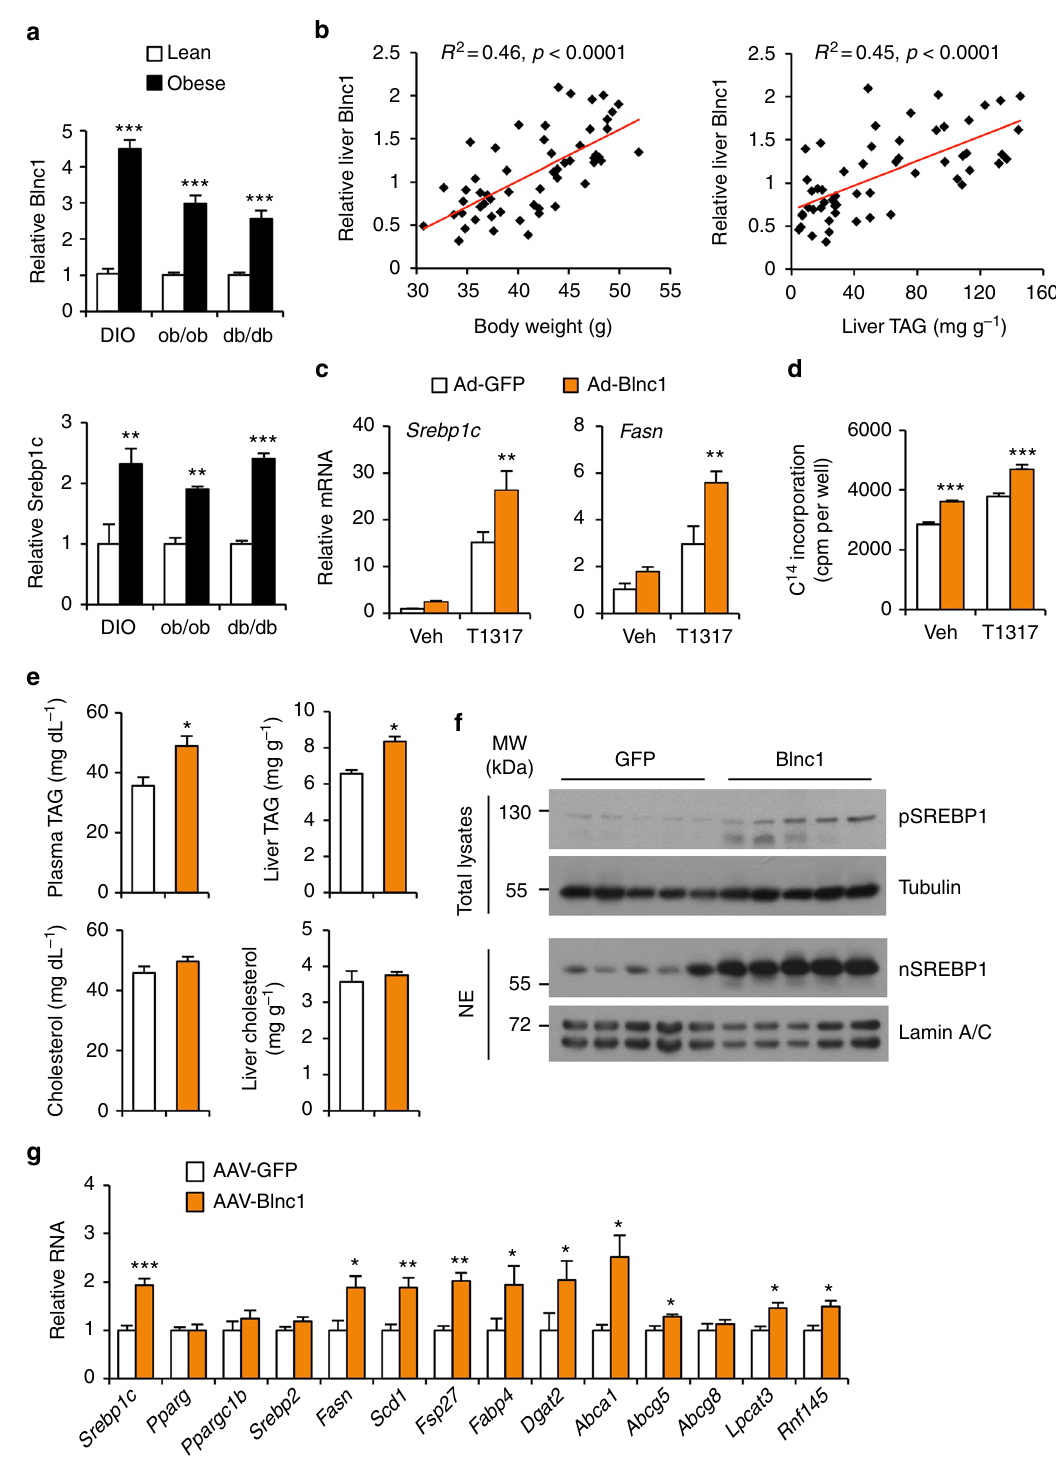
Fig. 1 Hepatic Blnc1 is linked to obesity and lipogenic activation. a qPCR analysis of Blnc1 and Srebp1c expression in the livers from lean (open) and obese ( fi lled) mice. For diet-induced obesity (DIO), WT mice were fed chow ( n = 4) or HFD ( n = 12) for 10 weeks. For genetic obesity, WT ( n = 5), ob/ob ( n = 3), or db/db ( n = 6) mice were fed standard chow. Data represent mean ±SEM. ** p <0.01, *** p <0.001, obese vs. lean, two-tailed unpaired Student ’ s t -test. b Correlation between liver Blnc1 RNA levels and body weight (left) or liver fat content (right) in HFD-fed mice. c qPCR analysis of gene expression in hepatocytes transduced with GFP (open) or Blnc1 ( fi lled) adenovirus followed by treatment with vehicle (Veh) or 5 μ M T0901317 (T1317) for 24h. d Incorporation of 14 C-acetate into lipids in transduced hepatocytes treated with Veh or T1317 for 24h. Data in ( c ) and ( d ) represent mean±SD ( n = 3). ** p < 0.01, *** p < 0.001, GFP vs. Blnc1, two-way ANOVA. e Plasma and liver TAG and cholesterol in mice transduced with AAV vectors expressing GFP ( n = 5) or Blnc1 ( n = 7). f Immunoblots of total liver lysates and liver nuclear extracts (NE) from transduced mice. g qPCR analysis of hepatic gene expression in transduced mice. Data in ( e ) and ( g ) represent mean±SEM. * p < 0.05, ** p <0.01, *** p <0.001, GFP vs. Blnc1, two-tailed unpaired Student ’ s t